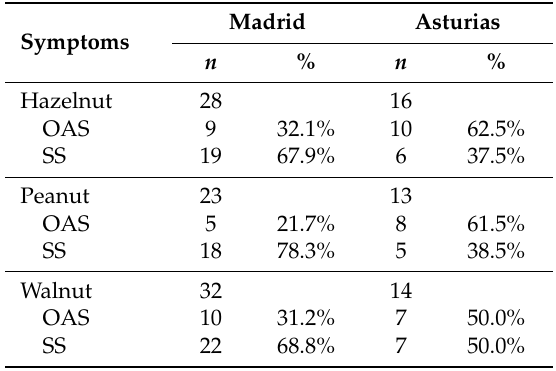
Table 6. Symptoms to nuts in patients from Madrid and Asturias.